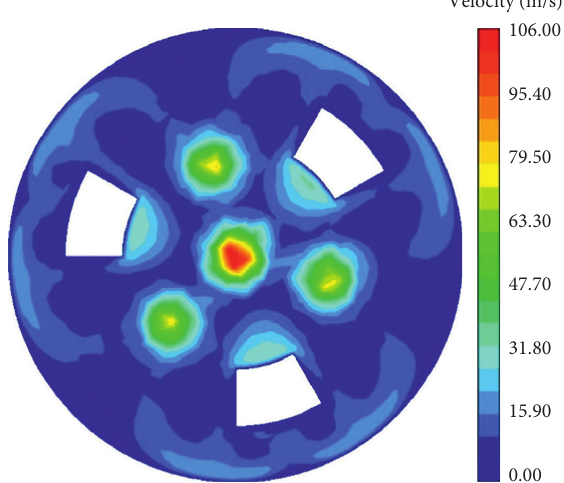
Figure 8: Bottom hole velocity distribution cloud image of the polymer additive jet.